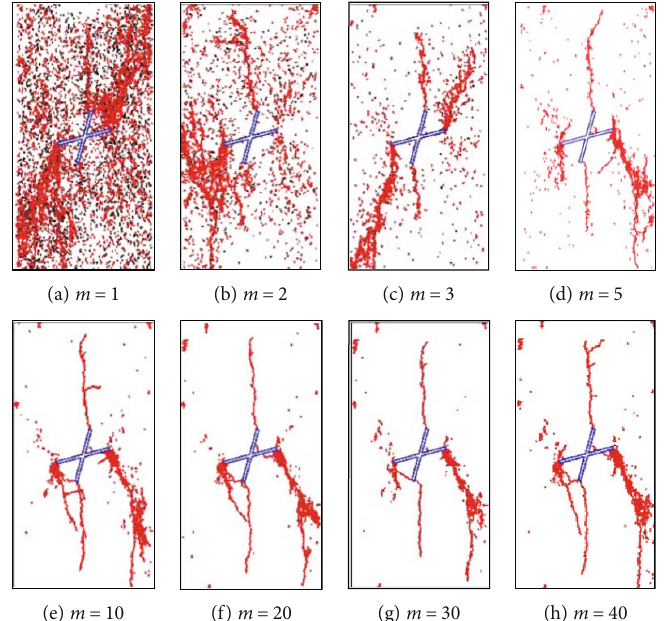
Figure 17: Failure modes of numerical models containing X-shaped fi ssure with di ff erent homogeneity factor values of m . (Red represents tensile microcracks. Black represents shear